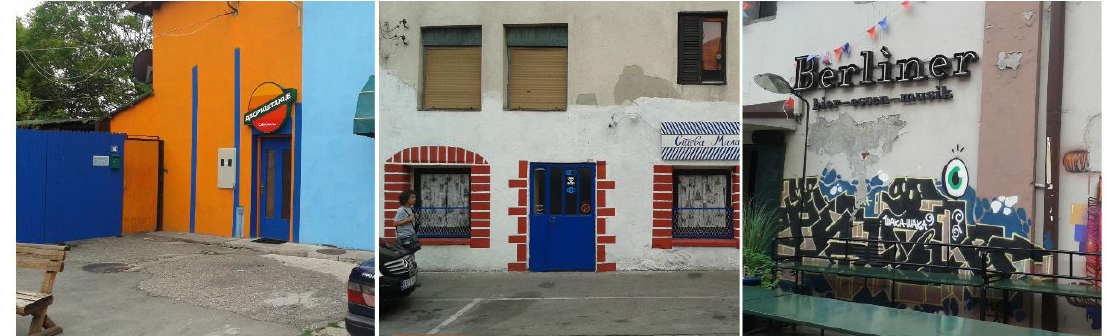
Figure 3. Local and international motives in Savamala (source: author’s collection, August 2015).